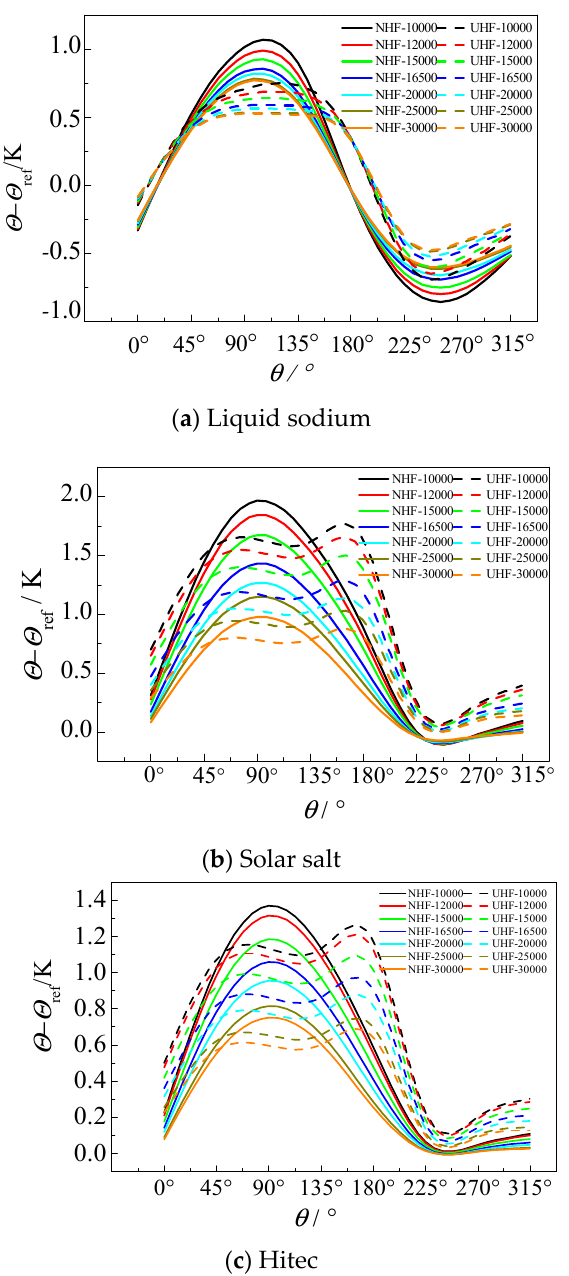
Figure 8. (a–c) Circumferential variation of the inner wall fluid temperature with the qualitative temperature for different Reynolds number at a fixed-inlet temperature ( T in =550 ° K ). ( a ) Pr =0.001 ( b ) Pr =13 ( c ) Pr =50. Solid lines: the present calculations; Dashed lines: homogeneous heat-flux model (HHFM).